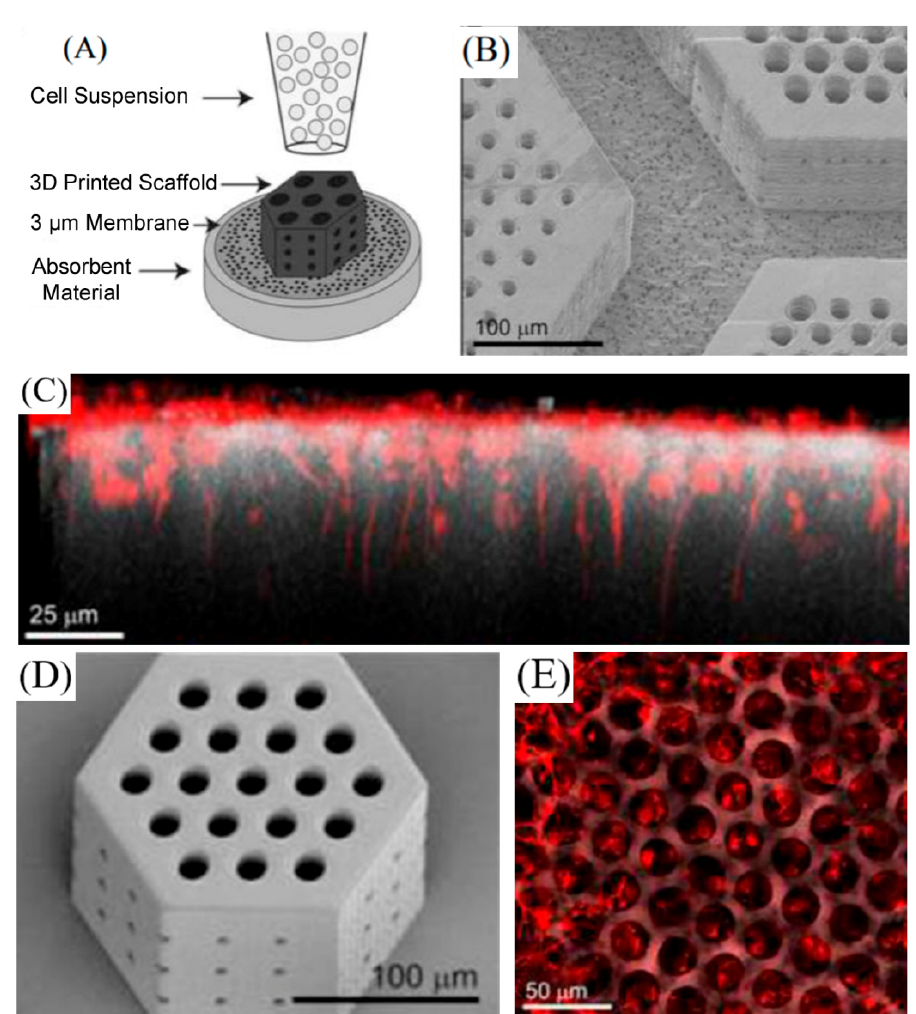
Figure 7. ( A ) Schematic of the retinal progenitor cell loading strategy. ( B ) Large photoreceptor cell porous membrane adhered to the membrane after processing. ( C ) Side view of retinal neurons (marked in red) settled in and aligned with 25 µ m vertical pores. ( D ) Representative scanning electron microscopy (SEM) image of a small retinal progenitor cell scaffold used to determine design-to-structure fidelity. ( E ) Sequential top-down images of retinal neurons (marked in red) on the surface of photoreceptor scaffolds and nestled in 25 µ m pores. Reproduced with permission from [57], Elsevier, 2017.